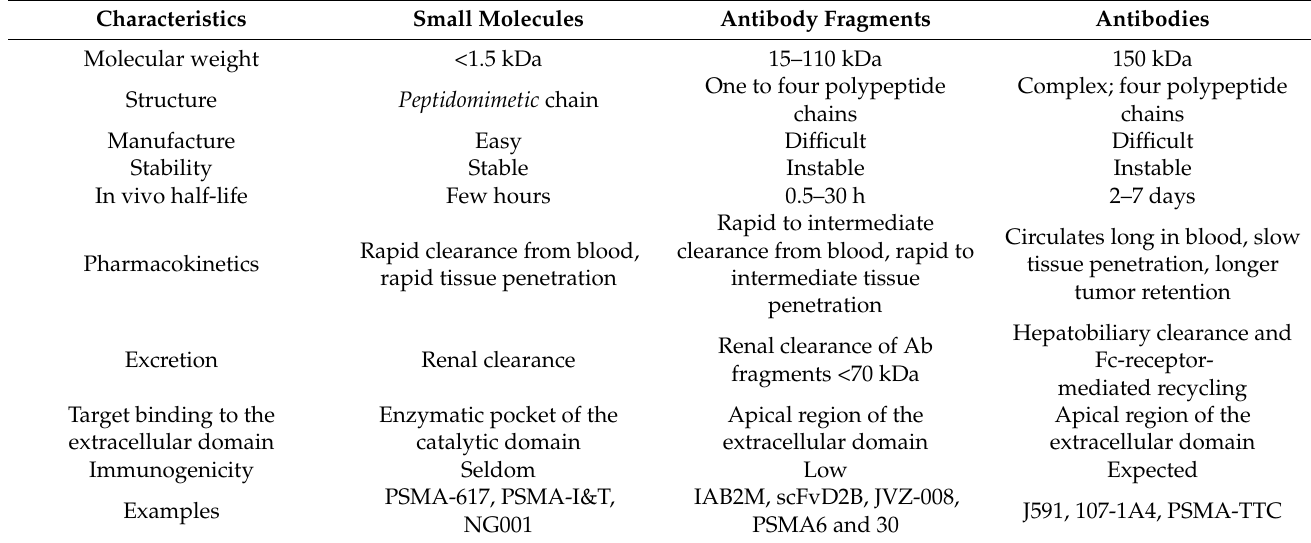
Table 3. Comparisons of prostate-specific membrane antigen (PSMA)-targeting small molecules, antibodies, and their fragments [55,76–80].